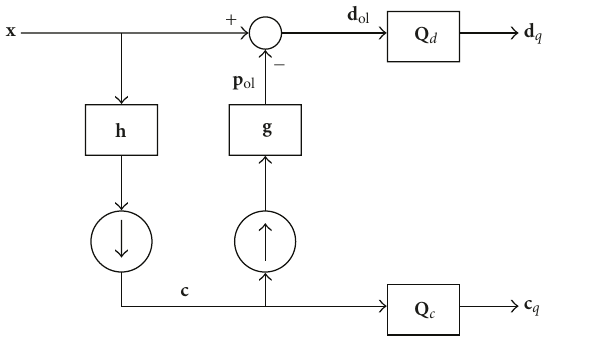
Figure 2: Closed-loop Laplacian pyramid structure with one de- composition level.